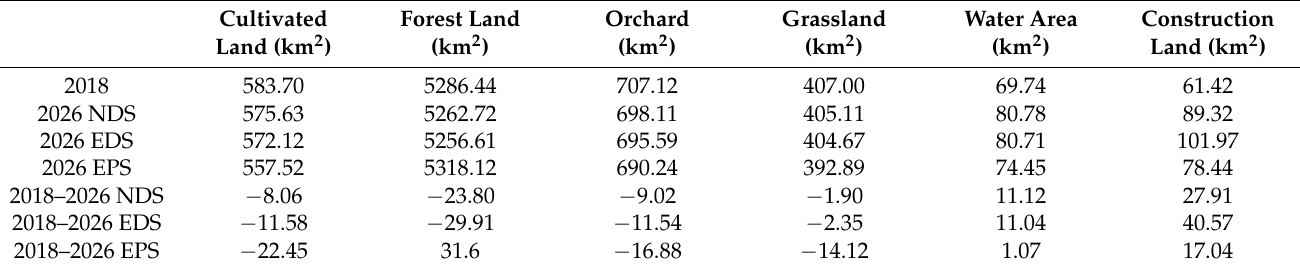
Table 5. Land-use change under different scenarios.